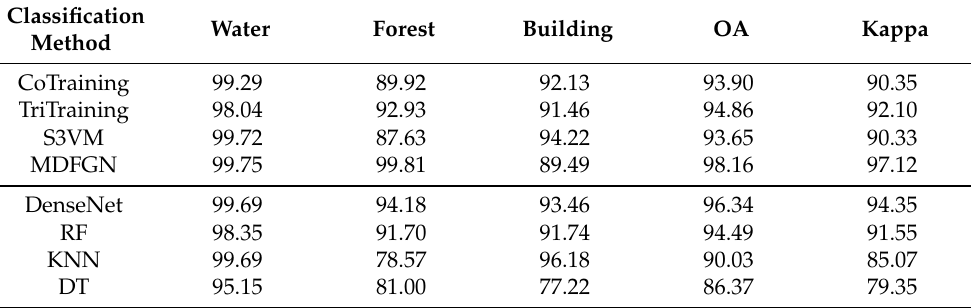
Table 1. Classification accuracy (%) on Rs2-Sanf Data.